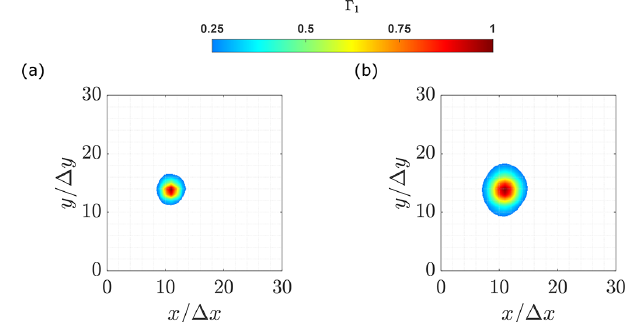
Figure 6. (cid:48) 1 magnitude for the area of interest, where the method- ology is applied after removing the average velocity from the field of view. (a) 8 points. (b) 24